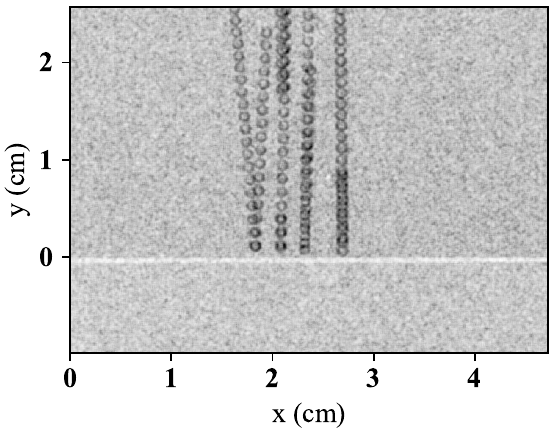
Figure 3. Example of images (strobed) used to track the par- ticles and estimate velocity, size and shape for determining the mechanical properties. Grain velocities in these ancillary exper- iments ranged from ∼ 20cm / s to ∼ 140cm / s. When estimating the diameter and eccentricity, the glass bar, the edge of which is at y = 0 in the image, is removed. The particles used here are (cid:104) d (cid:105) (cid:39)